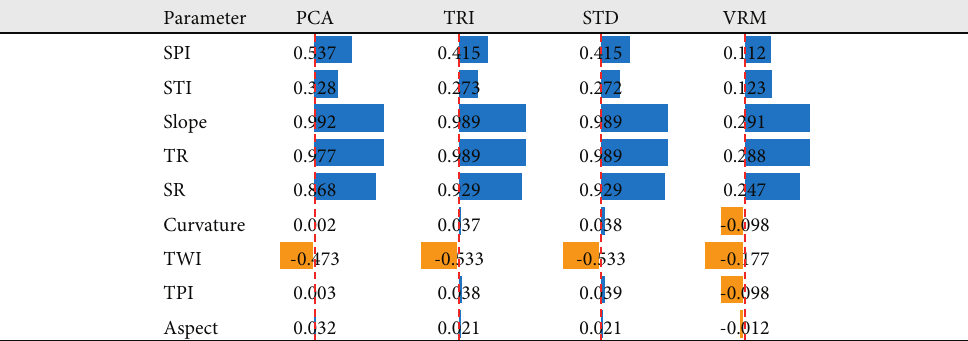
Table 3: Bivariate correlation of terrain metrics and ruggedness